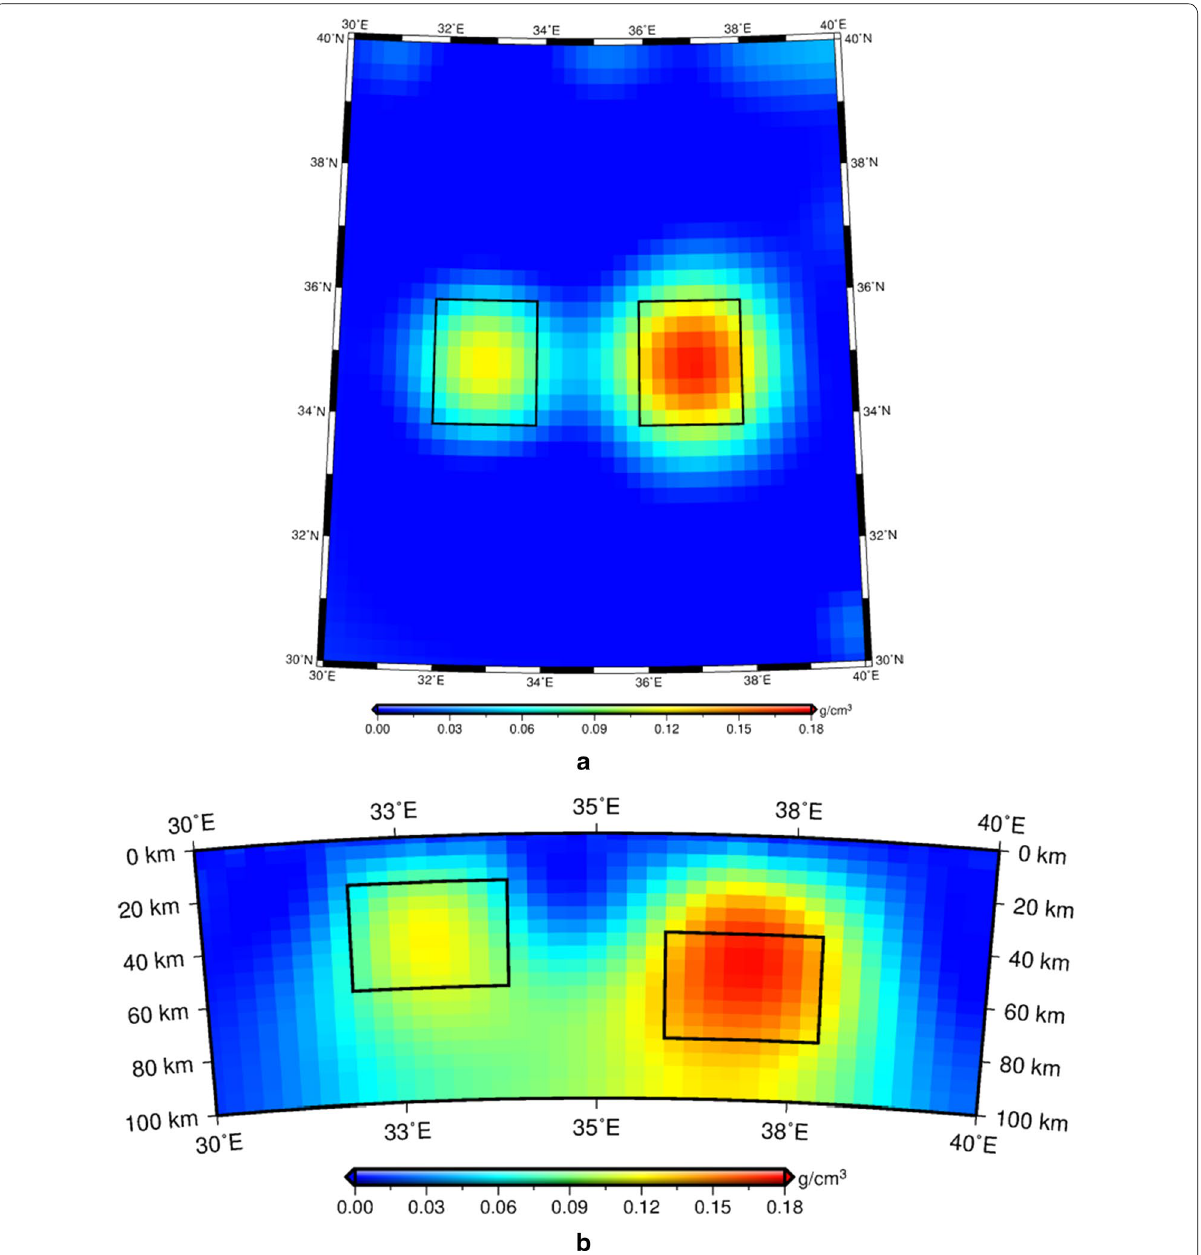
Fig. 13 Recovered density distribution for composite models. a Horizontal slice of the recovered model with a radial length of 1698 km, b vertical profile of the recovered model at the latitude of 35°